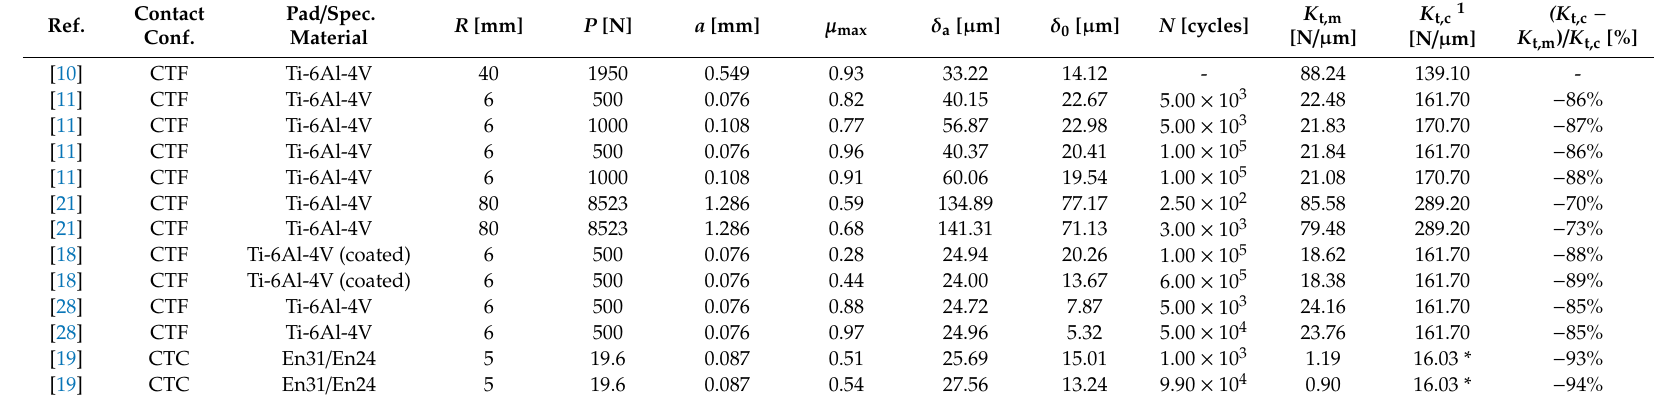
Table 2. Summary of the total tangential sti ff ness of di ff erent fretting tests found in the literature.